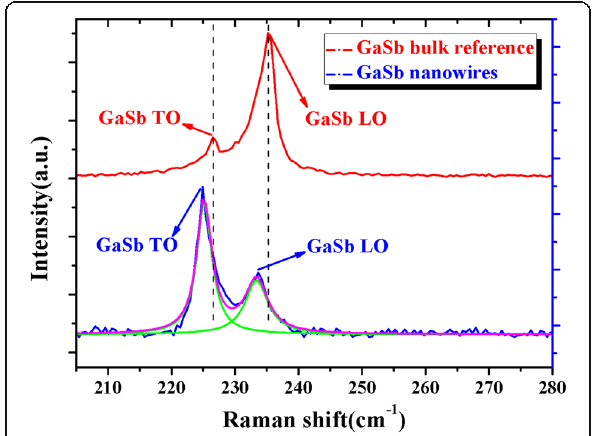
Fig. 7 Raman spectra of a GaSb (100) substrate ( red line ) and the GaSb nanowires ( blue line ). The green lines are results of multi-peaks Lorentzian